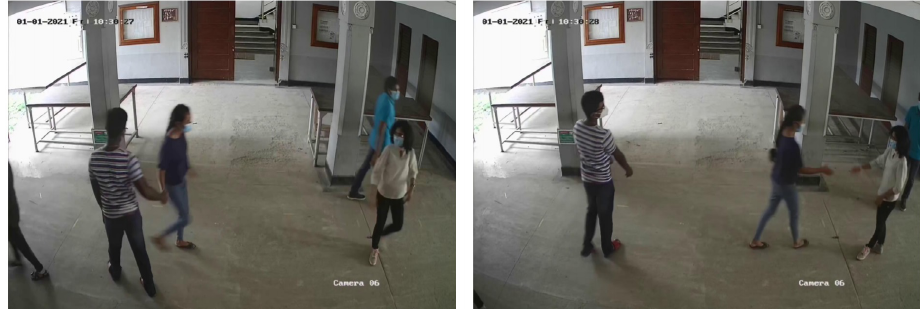
Figure 19. Edge case 2 threat level interpretations. System threat evaluation output—Increases, Human expert opinion